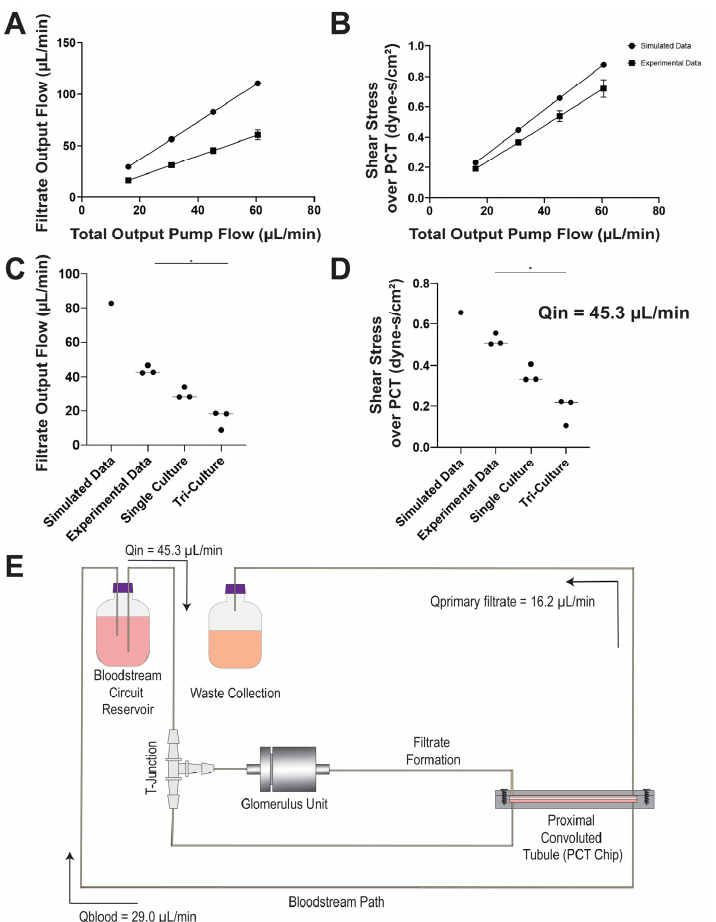
Figure 4. Simulated and experimental comparison of glomerulus and proximal convoluted tubule (PCT) MPS pump flow and shear stress. ( A ) Measured filtrate output flow ( µ L/min) for different total output pump flow ( µ L/min) in both simulated and experimental settings (0.25 mm ID tubing only). R 2 = 1.0. ( B ) Shear stress across the apical PCT (dyne-s/cm 2 ) for different total output pump flow ( µ L/min) in both simulated and experimental settings (0.25 mm ID tubing only). R 2 = 1.0. ( C ) Scatter plot of simulated, experimental (single inlet tubing), single-culture, and tri-culture filtrate output flow under Q in = 45.3 µ L/min. ( D ) Scatter plot of simulated, experimental (single inlet tubing), single-culture, and tri-culture shear stress (dyne-s/cm 2 ) under Q in = 45.3 µ L/min. ( E ) Assembled MPS flow validation. Line represents median. (* Comparison of datapoints within conditional test, p < 0.05, non-parametric one-way